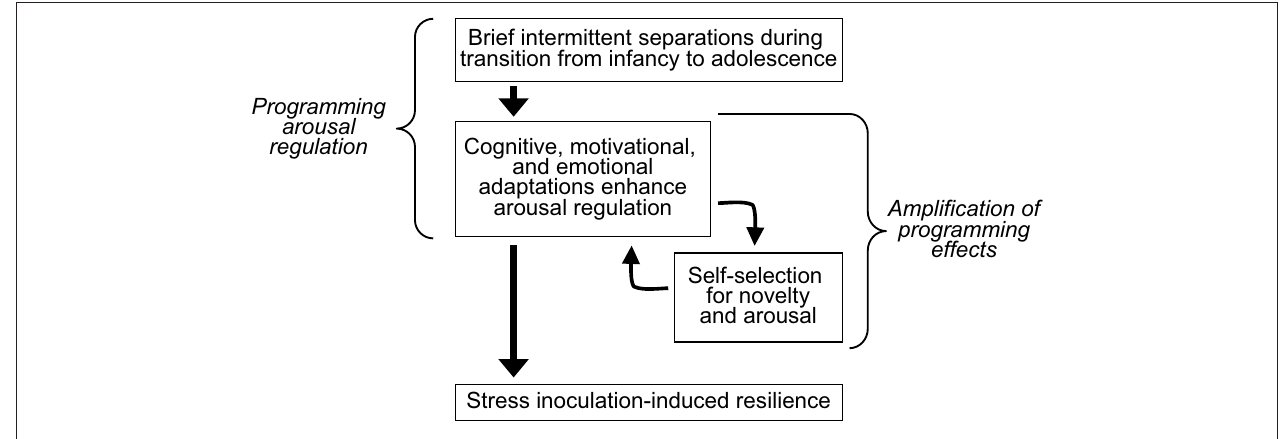
FIGURE 1 | Developmental cascade model of stress inoculation-induced resilience. Coping with brief intermittent separations that simulate a naturally